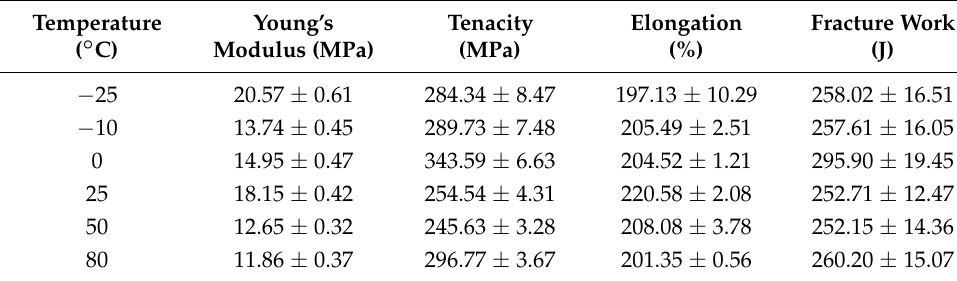
Table 1. Mechanical properties of the PCTF at different